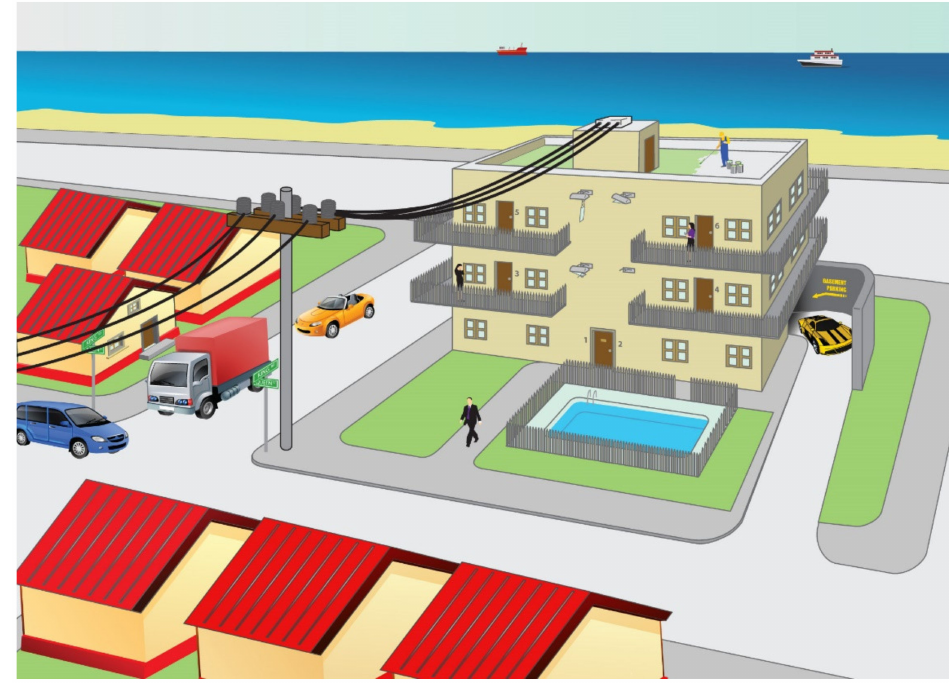
Figure 2. The risk scenario description supporting